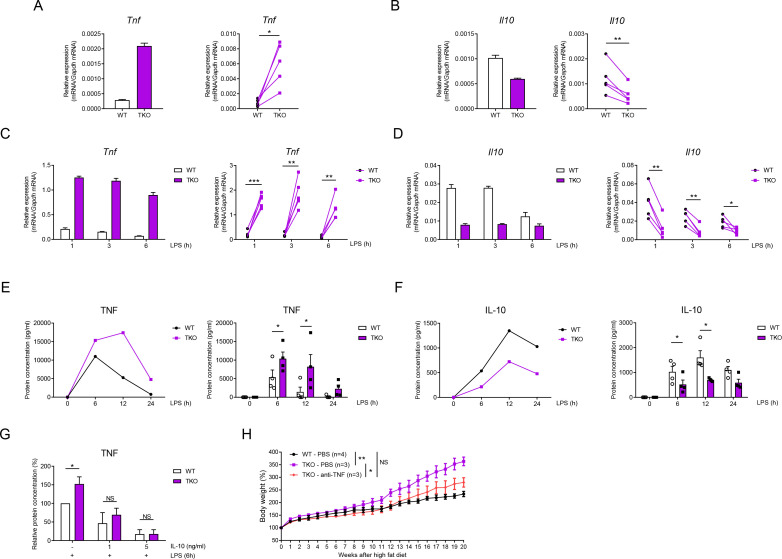
miR-17~92 family miRNAs balance the production of TNF and IL-10 in macrophages.(A and B) qPCR analysis of Tnf (A) and Il10 (B) mRNA in WT and TKO BMDMs without stimulation. (C and D) qPCR analysis of Tnf (C) and Il10 (D) mRNA in WT and TKO BMDMs stimulated for the indicated periods with LPS. (E and F) ELISA of TNF (E) and IL-10 (F) in supernatants from WT and TKO BMDMs stimulated for the indicated periods with LPS. (G) ELISA of TNF in supernatants from WT and TKO BMDMs pre-treated 1 hr with indicated dose of IL-10 and then stimulated with LPS for 6 hr. (H) WT and TKO mice were injected with PBS or anti-TNF (10 mg/kg) weekly and were fed with a high-fat diet. Body weight of each mice was measured weekly. NS, not significant (p>0.05); *p<0.05, **p<0.01, and ***p<0.001 (paired Student’s t-test and two-way ANOVA). Data are representative of or are pooled from five (A–D), four (E and F), three (G), or one (H) independent experiments (mean + s.d. in A–G and mean ± sem in H).